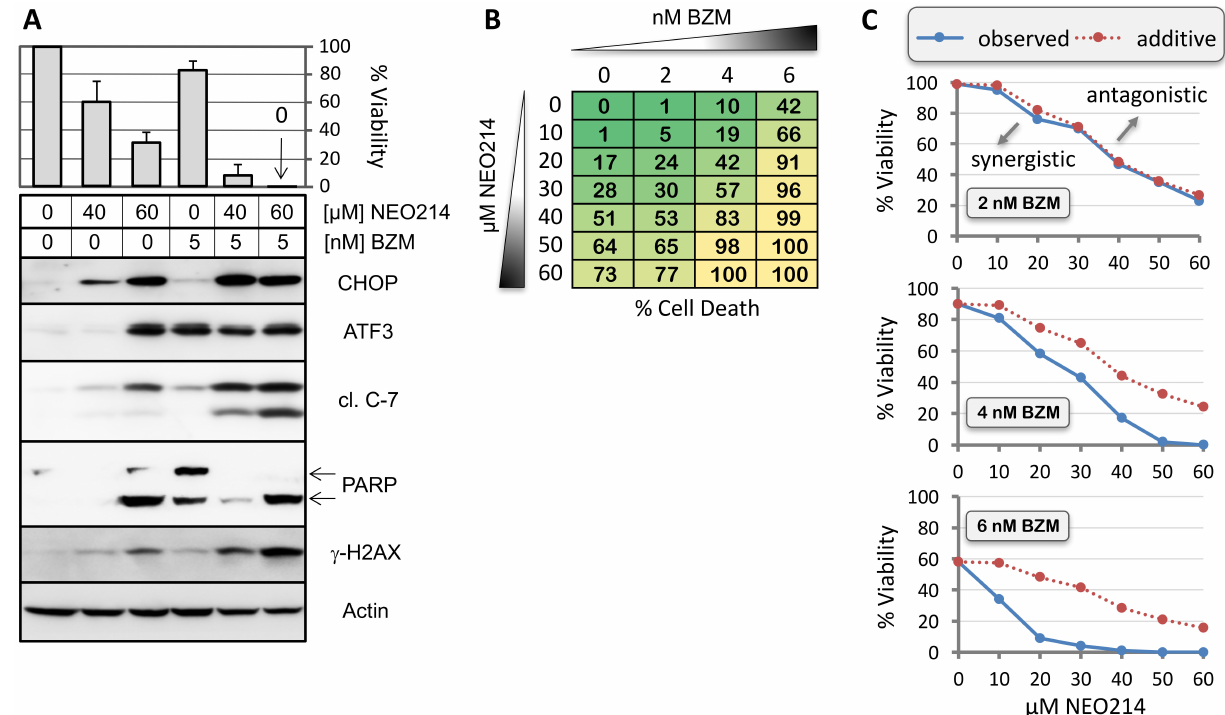
Figure 10. NEO214 synergizes with bortezomib. RPMI/8226 cells were treated with NEO214 alone, bortezomib (BZM) alone, or both in combination. ( A ) Top panel shows cell viability after 48 h of treatment, as determined by MTT assay. Bottom panel shows expression levels of ER stress markers and indicators of apoptosis after 24 h of treatment, as determined by Western blot analysis. Note that the effects of BZM alone on several of these markers were fairly weak, but were substantially enhanced in the presence of NEO214. ( B ) Percent cell death in response to increasing concentrations of BZM (0–6 nM) combined with increasing concentrations of NEO214 (0–60 µ M) after 48 h, as determined by MTT assay (averages from six measurements). ( C ) Statistical analysis of drug combination effects of BZM plus NEO214. Dotted red line represents the predicted (i.e., calculated) combination effect (Y P ) based on the Bliss independence model, which signifies additive effect. Blue straight line shows the observed (i.e., measured) combination response (Y O ). Overlap of blue line with red line in top graph indicates additive effects at 2 nM BZM. Higher BZM concentrations (4 and 6 nM, middle and bottom panels) result in separation of the lines and pronounced left-shift of blue line, indicating strong synergistic effects. Similar effects were also obtained with U266